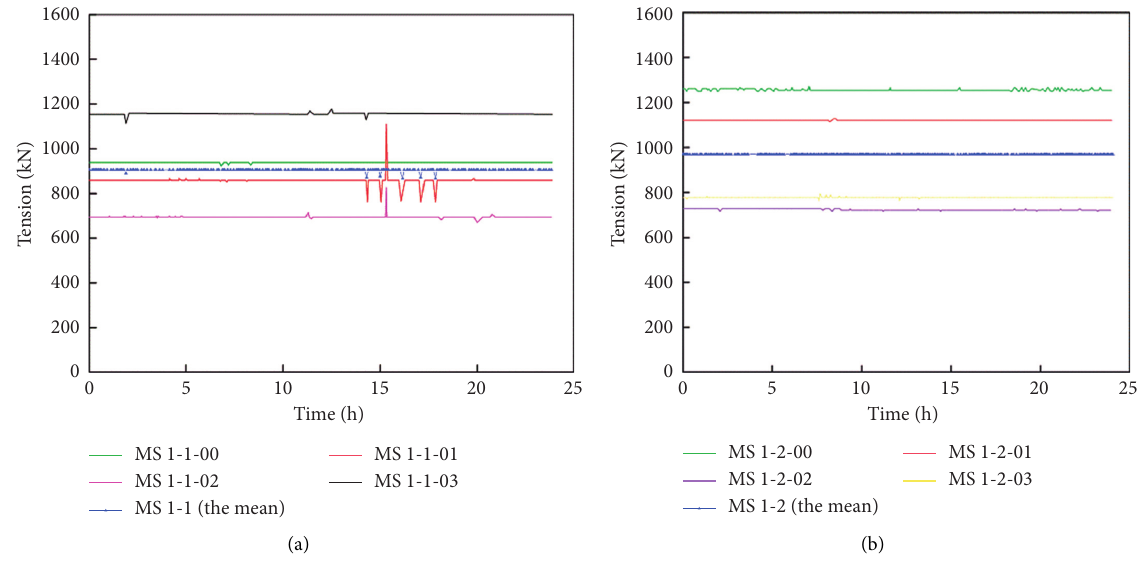
Figure 1: Test result curve of the anchor cable dynamometer in the water pressure test: (a) section 1; (b) section 2.